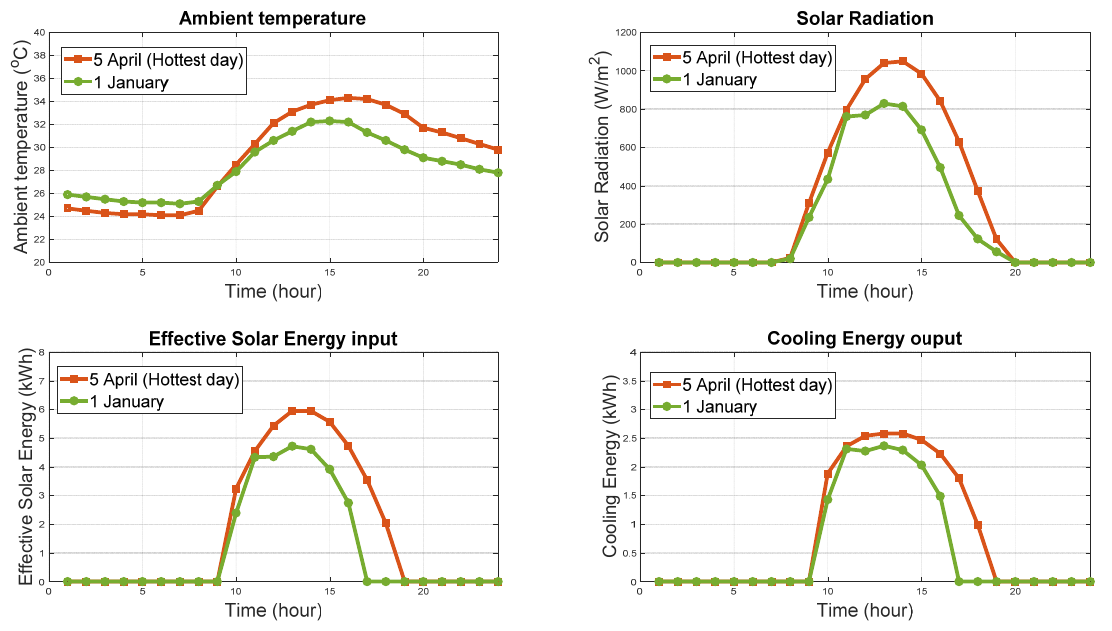
Figure 9. Examples of hourly daily cooling production (1 January and 5 April).